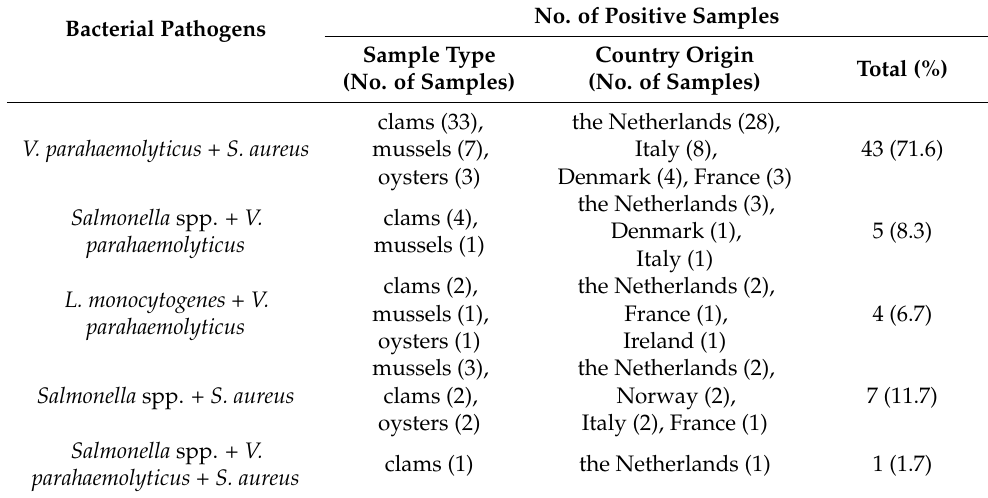
Table 4. Simultaneous occurrence of bacterial pathogens in bivalve molluscs samples (n = 60).